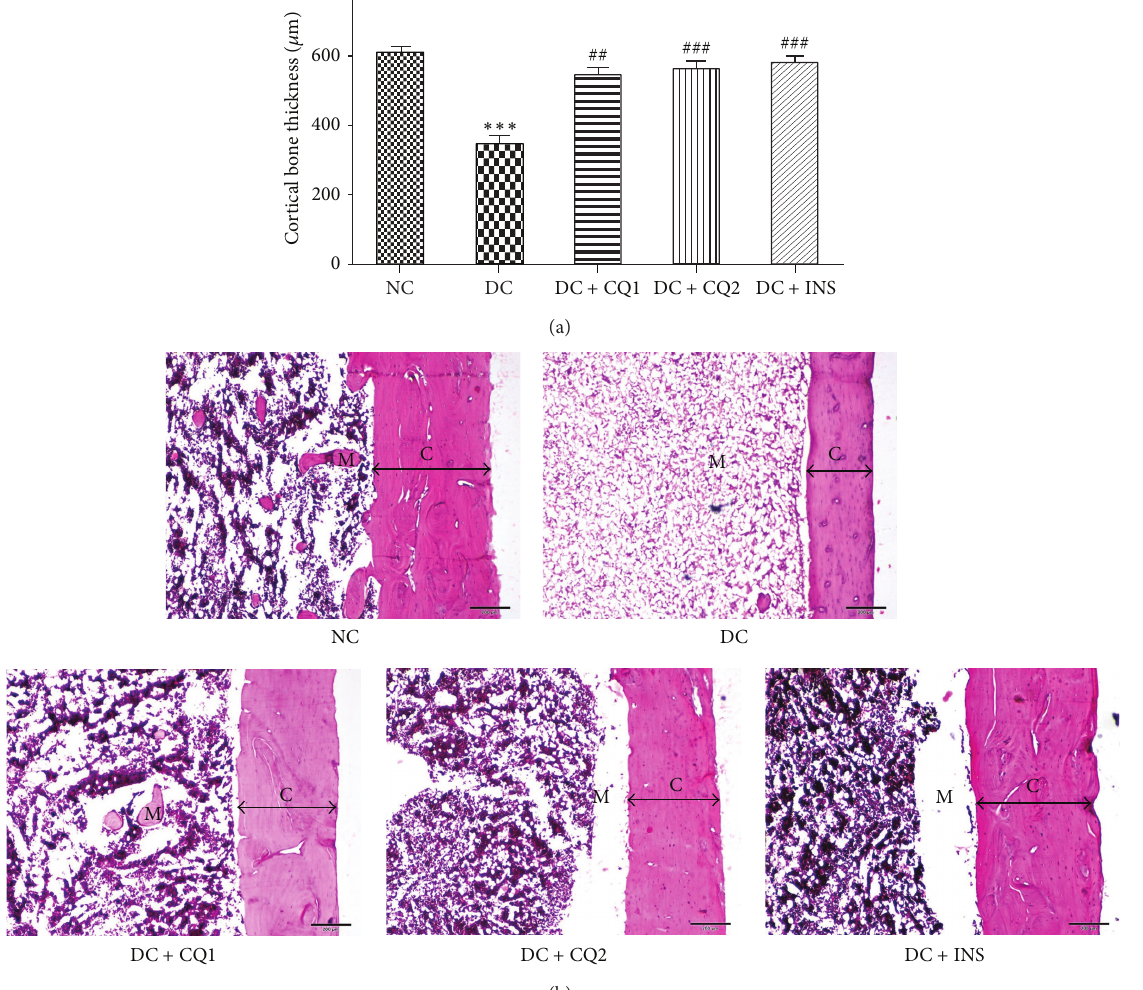
Figure 3: (a) Effect of PECQ on mean thickness of cortical bone. Thickness of the cortical bone significantly decreased in diabetic control (DC) rats when compared to normal control (NC) rats. Treatment with two different doses of PECQ (DC + CQ1 and DC + CQ2) or with insulin (DC + INS) significantly increased the bone thickness in diabetic rats when compared to nontreated diabetic rats. ∗∗∗ 𝑃 < 0.001 when compared to NC group; ### 𝑃 < 0.001 , ## 𝑃 < 0.01 when compared to DC group. (b) Photomicrographs of cortical bone. Thickness of the cortical bone was significantly less in the diabetic control group (DC) when compared to normal control group (NC). Further treatment with two doses of the PECQ (DC + CQ1, DC + CQ2) and insulin (DC + INS) improved the cortical bone growth. C: cortical bone; M: medullary cavity; H and E staining, scale bar: 200 𝜇